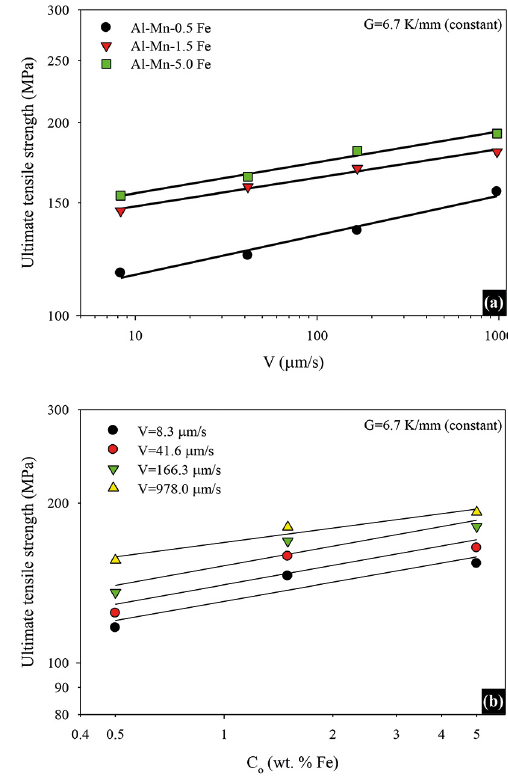
Fig. 10. (a) Variation of the ultimate tensile strength with the V for different C (b) Variation of the ultimate tensile strength with the o for different V C o